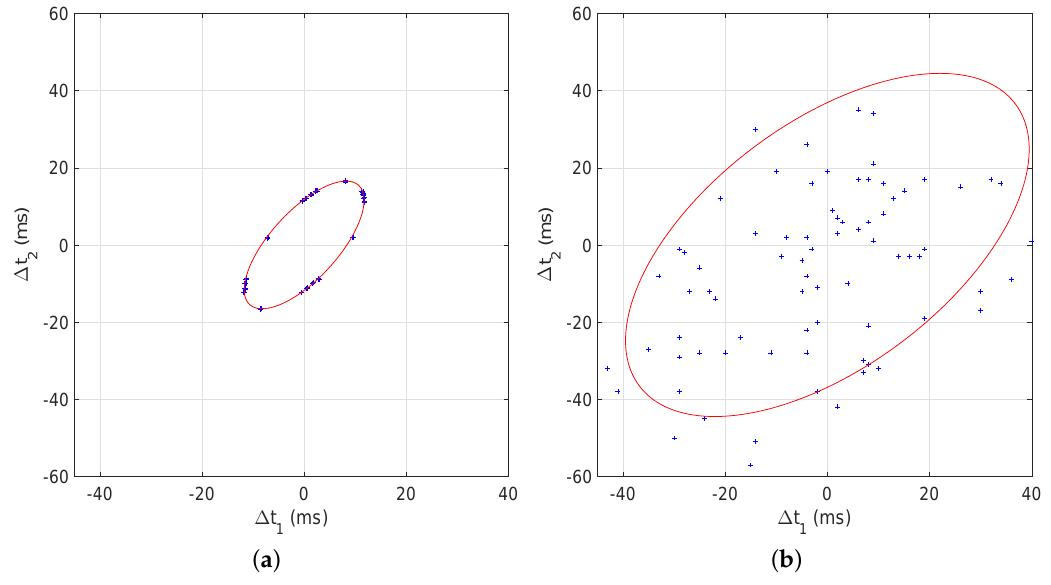
Figure 13. Comparison of the ellipsoids between simulated TDOA measurements and TDOA measurements obtained with our Android application. ( a ) Ellipsoid between S 1 , S 2 and S 6 with simulated TDOA measurements where σ = 0.1 ms; ( b ) ellipsoid between S 1 , S 2 and S 6 with our real measurement